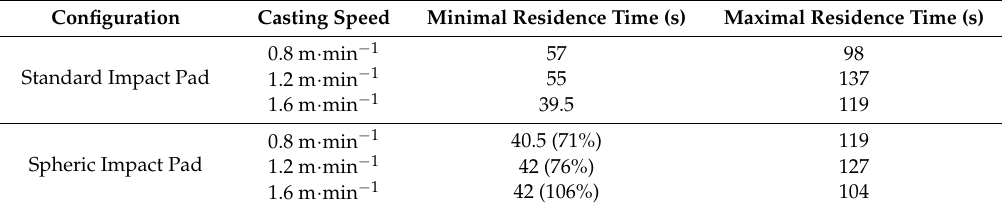
Table 1. Comparison of residence times for all tested